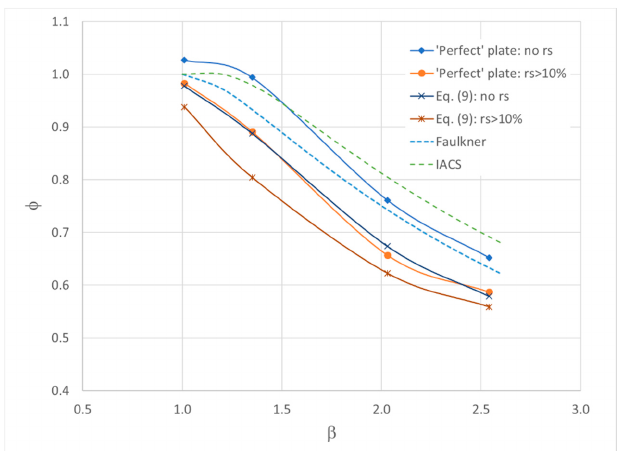
Figure 14. Comparison of results for constraint plates considering residual stress and initial imperfections and standard